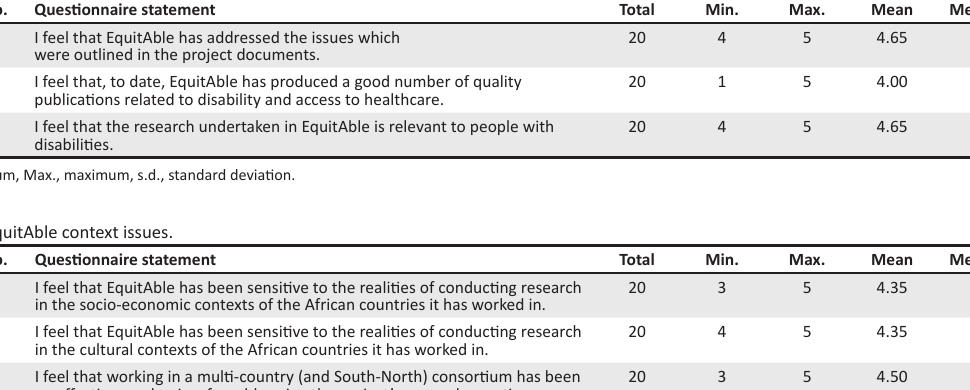
TABLE 1: EquitAble content issues. Question no.